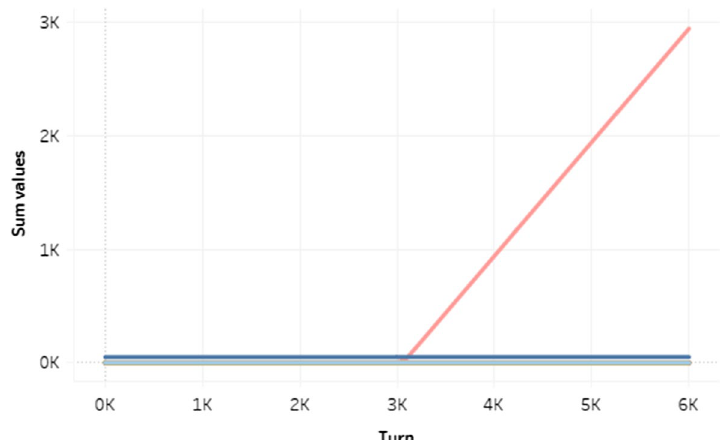
Fig. 11 Airdrop, case 2-F: Time series transition in the sum of possession of each good. Case 2-F is a case in which the rarity threshold is set to 25, cryptocurrency can be selected as a utility (with the cryptocurrency agent) and 1 unit is distributed to one specific person each turn. Blue line is the fiat money good, red line is the cryptocurrency good, and other colors represent remaining goods. Since the cryptocurrency is not consumed even when the airdrop is completed each turn, it continues to increase monotonically